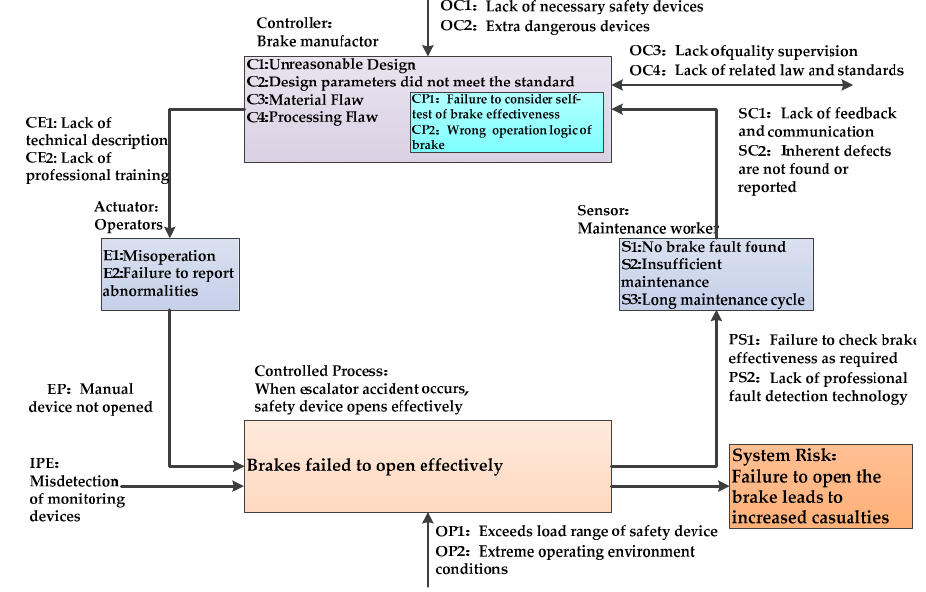
Figure 11. Unsafe control action identification of Level 1.